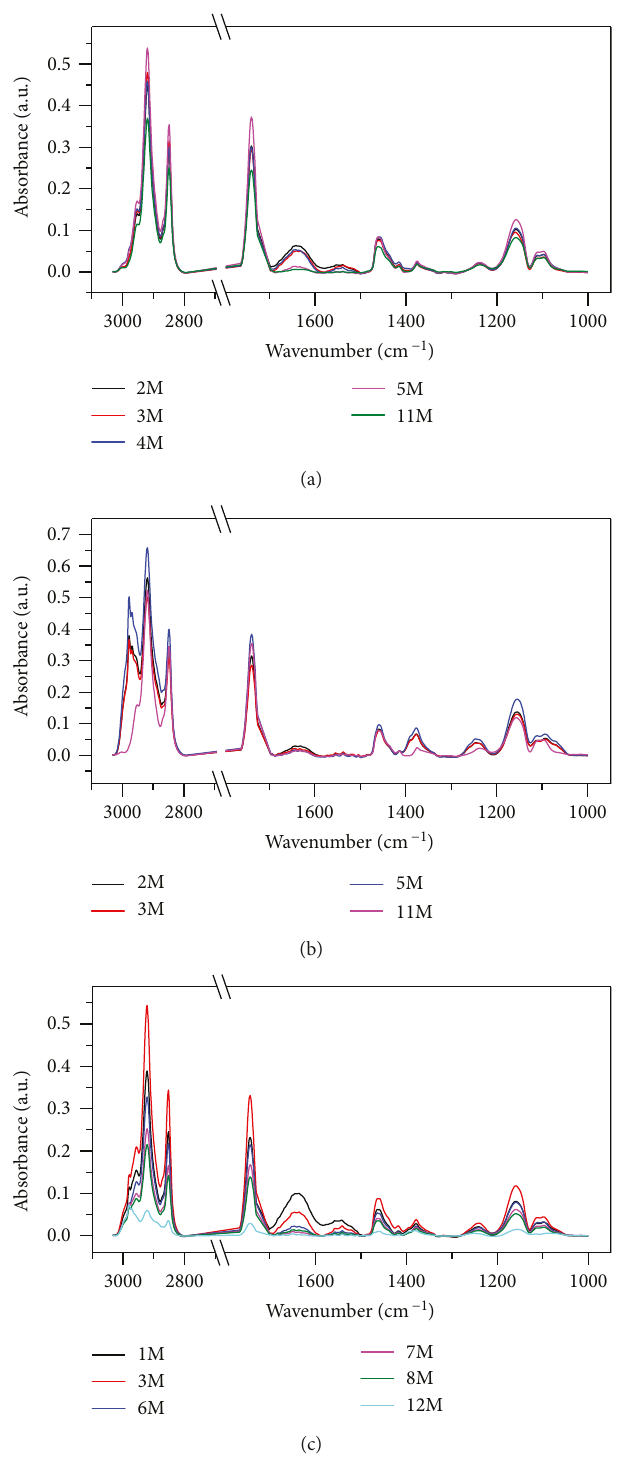
Figure 1: Fourier transform infrared spectra (3700 to 1000cm − 1 ) of Pecorino (a), Gouda (b), and ewes ’ ripe (c) cheese samples during ripening. M: